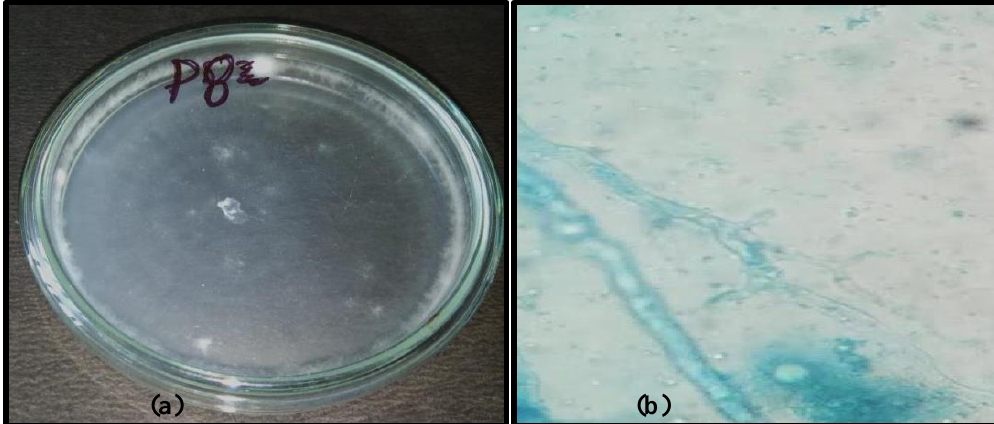
Figure 1. Porostereum sp. HGBS16 (a) Colony on PDA plate and (b) Mycelium (under 40X magnification)